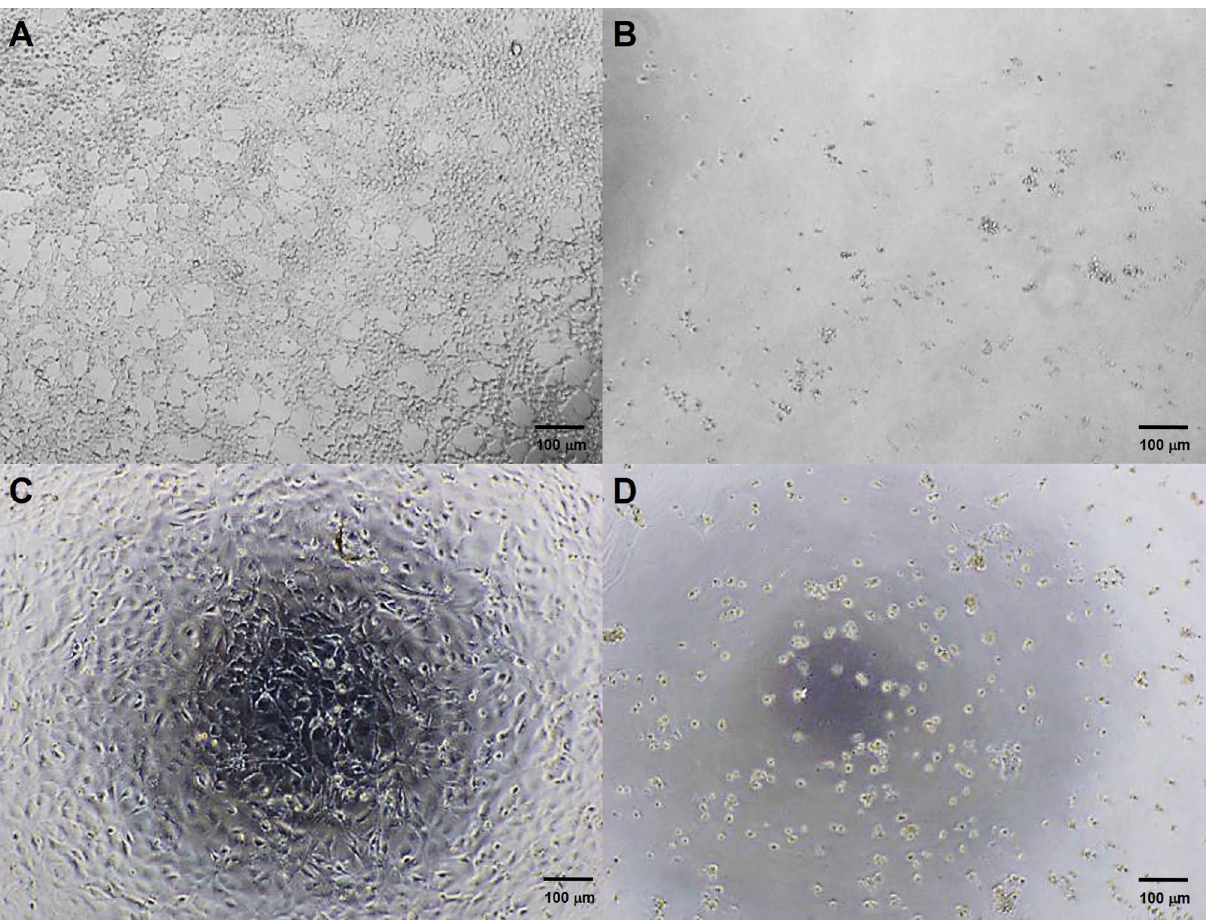
Figure 4. The minimum inhibitory concentration (MIC) of puromycin for the cells at day 5. ( A ) HEK293T with 0 µg/mL puromycin showed confluent adherent cells with a characteristic morphology, ( B ) HEK293T